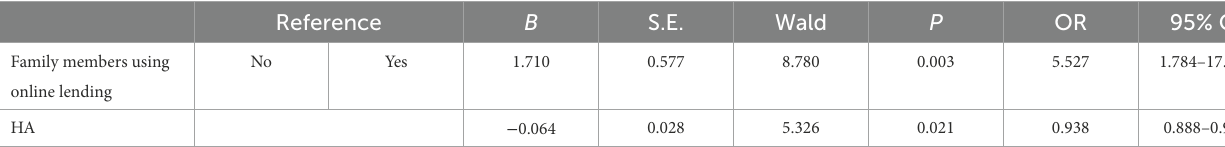
TABLE 5 Binary logistic regression of online lending for females.